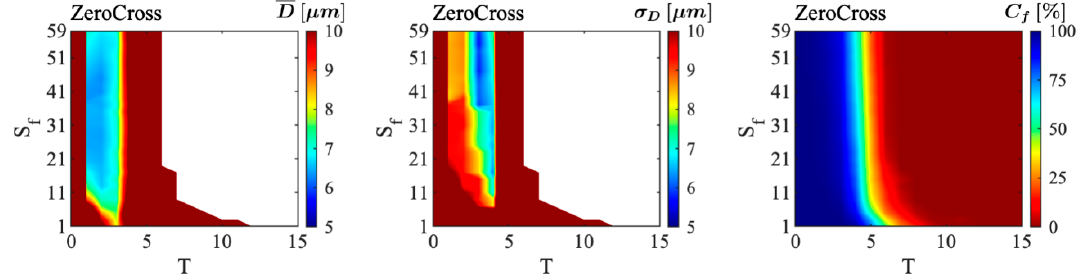
Figure 8. MQI results as a function of 𝑆 (cid:3033) calculated with ZeroCross for 𝑆𝑂1 in a reduced 𝑇 range.